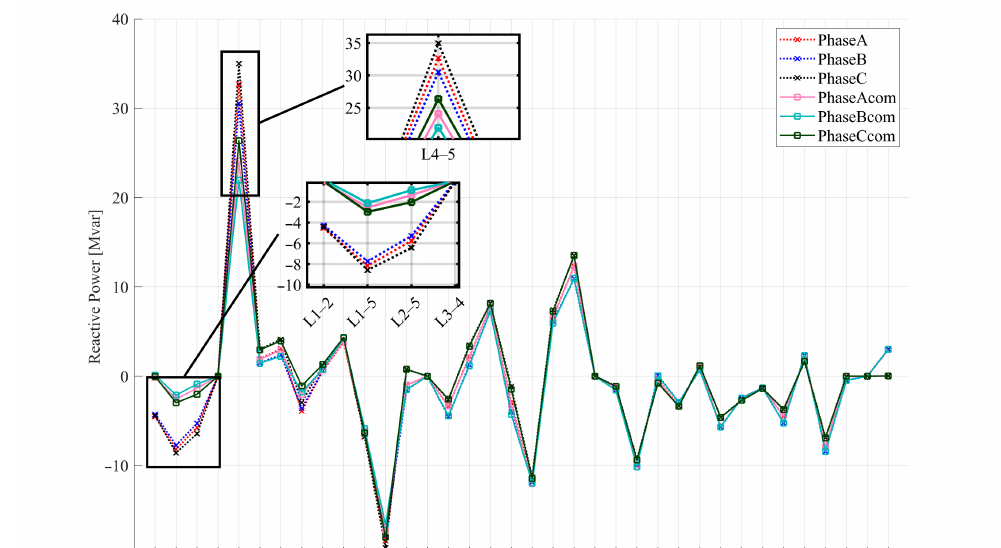
Figure 9. Voltage magnitude.